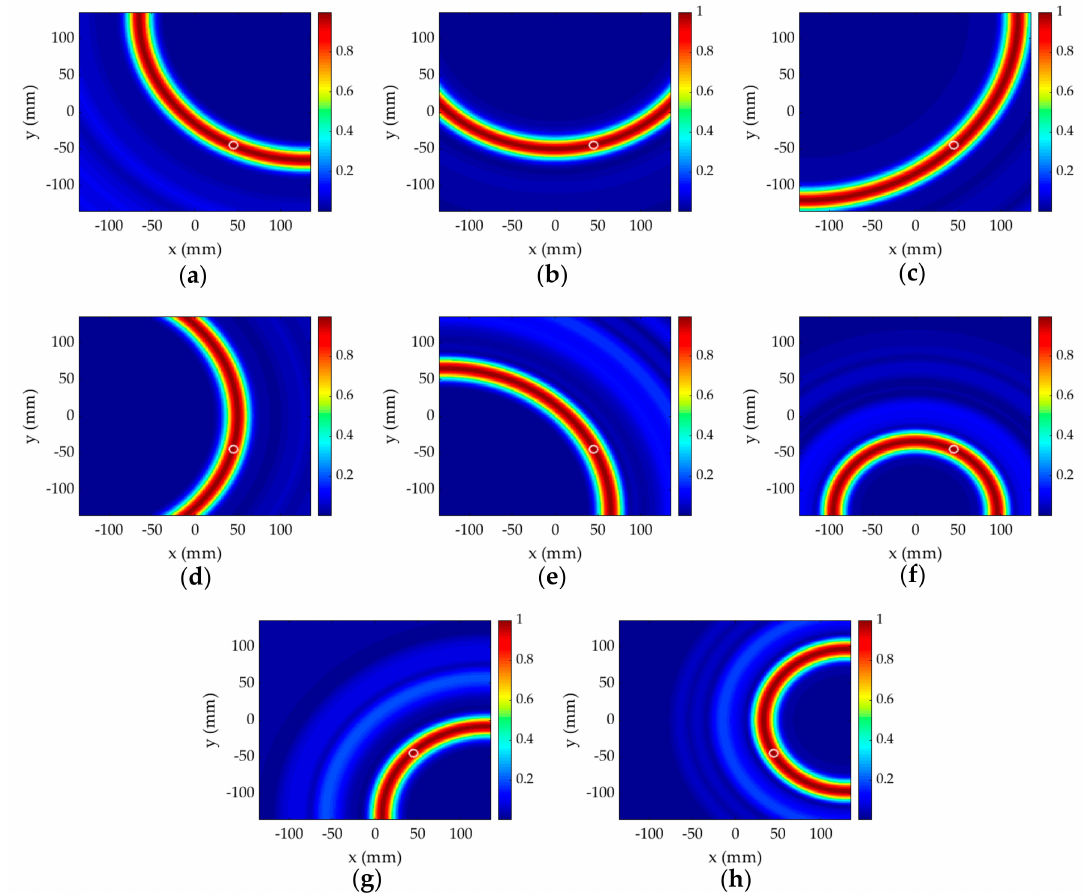
Figure 14. Possibilities of damage existence with time compensation in pulse–echo configuration for sensing paths: ( a ) A1B1; ( b ) A2B2; ( c ) A3B3; ( d ) A4B4; ( e ) A5B5; ( f ) A6B6; ( g ) A7B7; ( h )